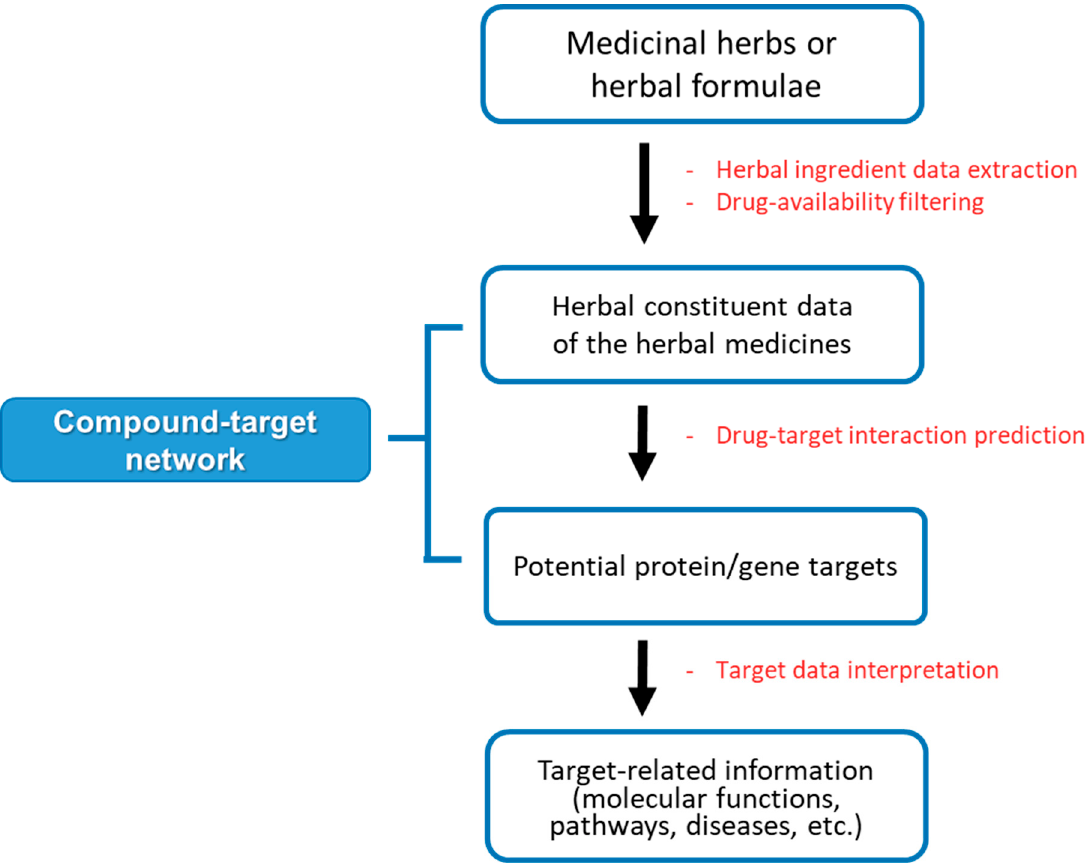
Figure 1. The general framework of network pharmacology analysis of herbal medicine.